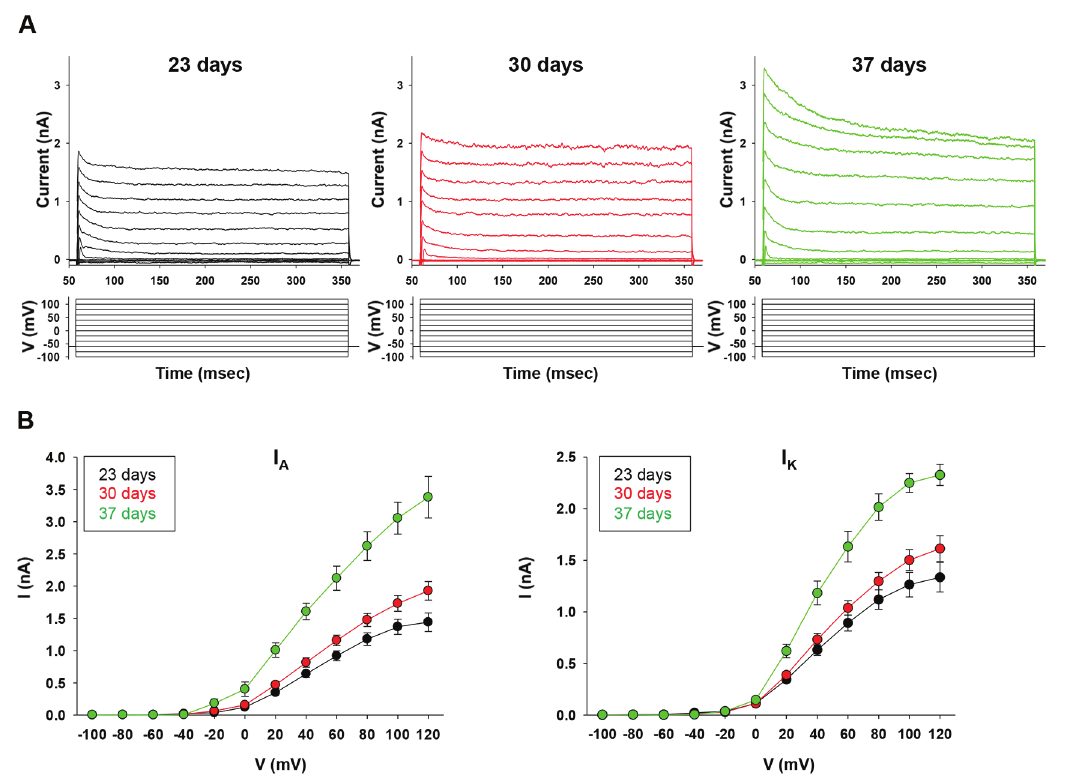
Figure 3. Voltage clamp recordings of K + currents. ( A ) Representative traces for voltage clamp recordings at day 23 (black), 30 (red) and 37 (green). Membrane potential was held at -60 mV and current (nA) is shown following 12 consecutive pulses of 20 mV voltage steps from -100 to +60 mV. ( B ) I-V curves for I and I currents for the same time-points as in ( A ). Sample size: n=21 at day 23; n=25 at day 30; n=23 at A K day 37. Values are mean ±